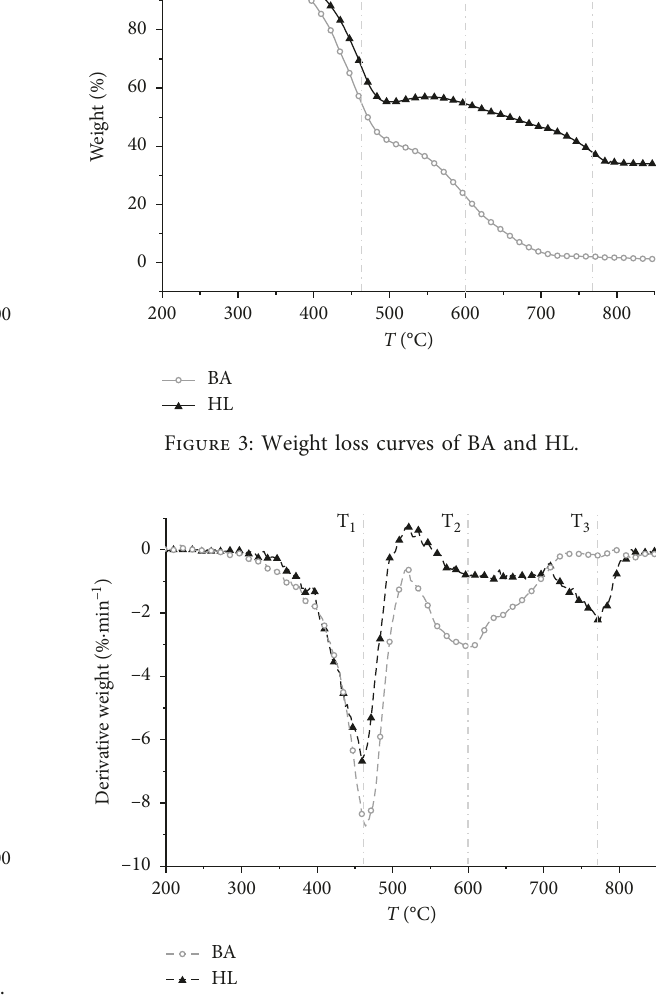
Figure 4: Derivative weight loss curves of BA and